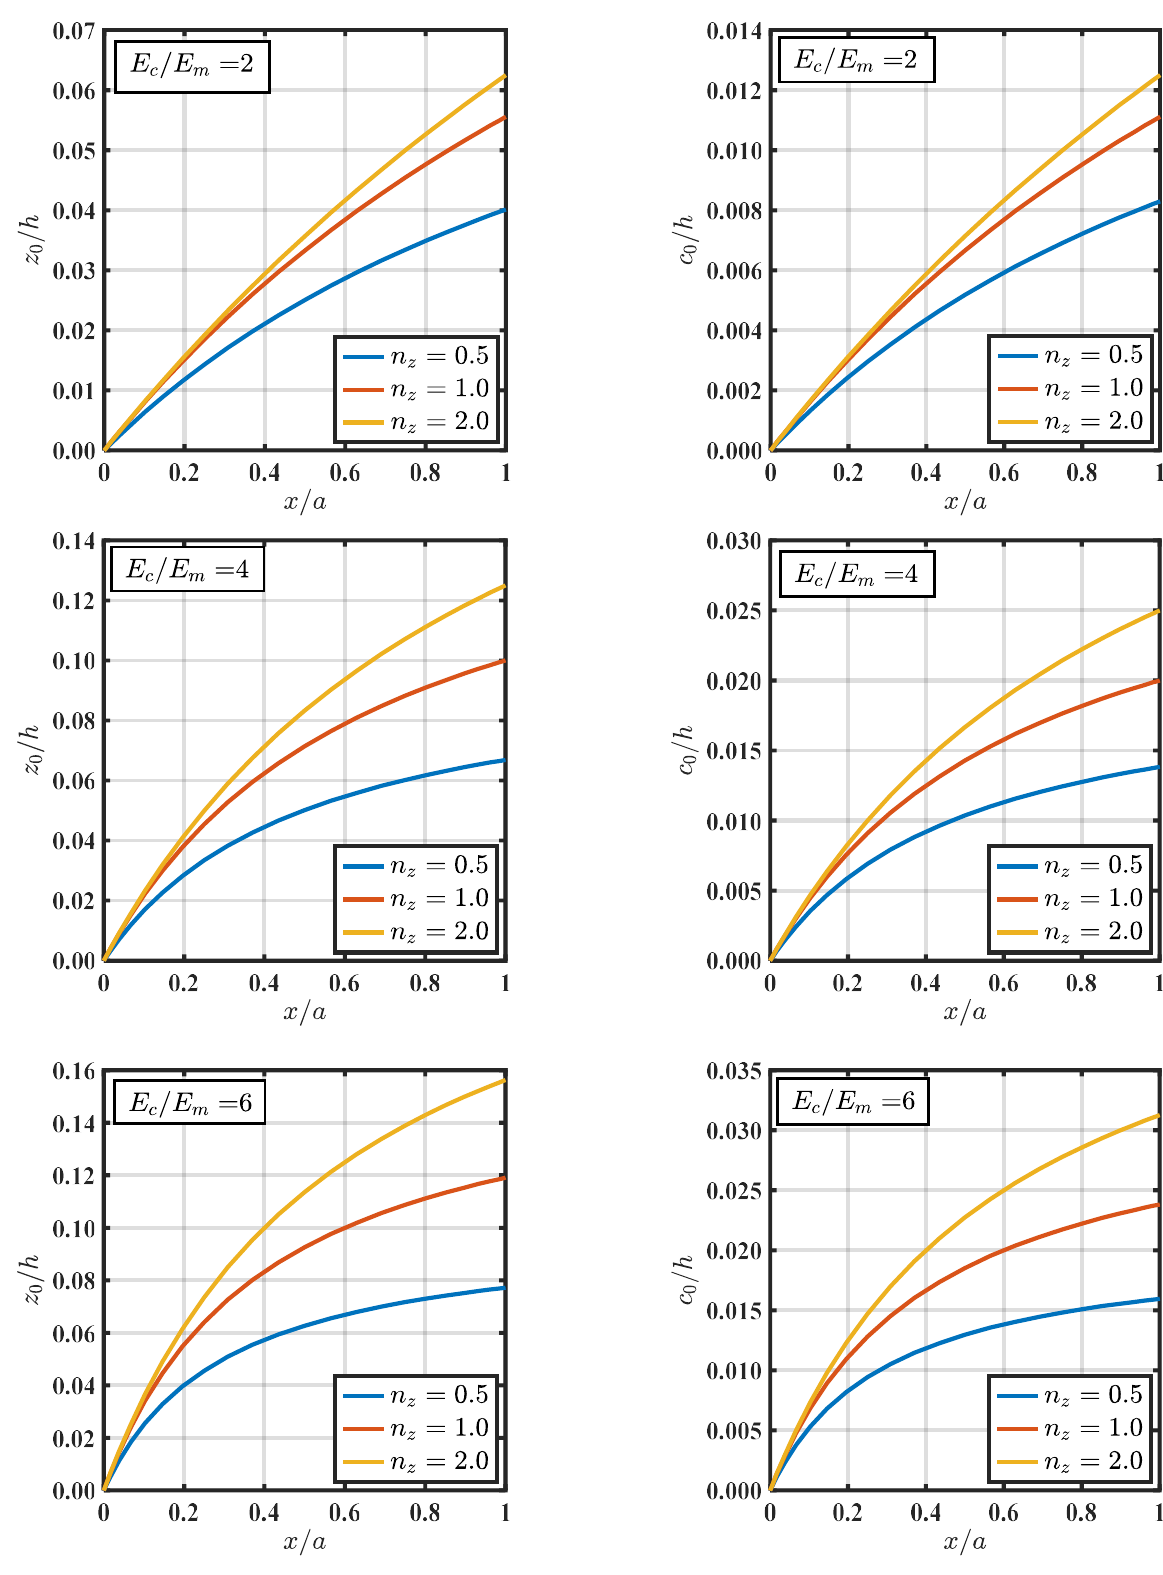
Figure 3. Plots of 𝑧 (cid:2868) (𝑥) and 𝑐 (cid:2868) (𝑥) at different 𝑛 (cid:3053) and 𝐸 (cid:3030) 𝐸 (cid:3040) ⁄ ratios ( 𝑛 (cid:3051) =